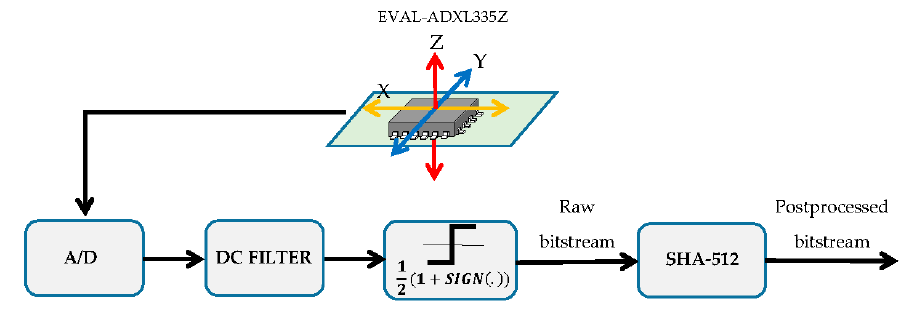
Figure 8. Conceptual block diagram of the processing performed.